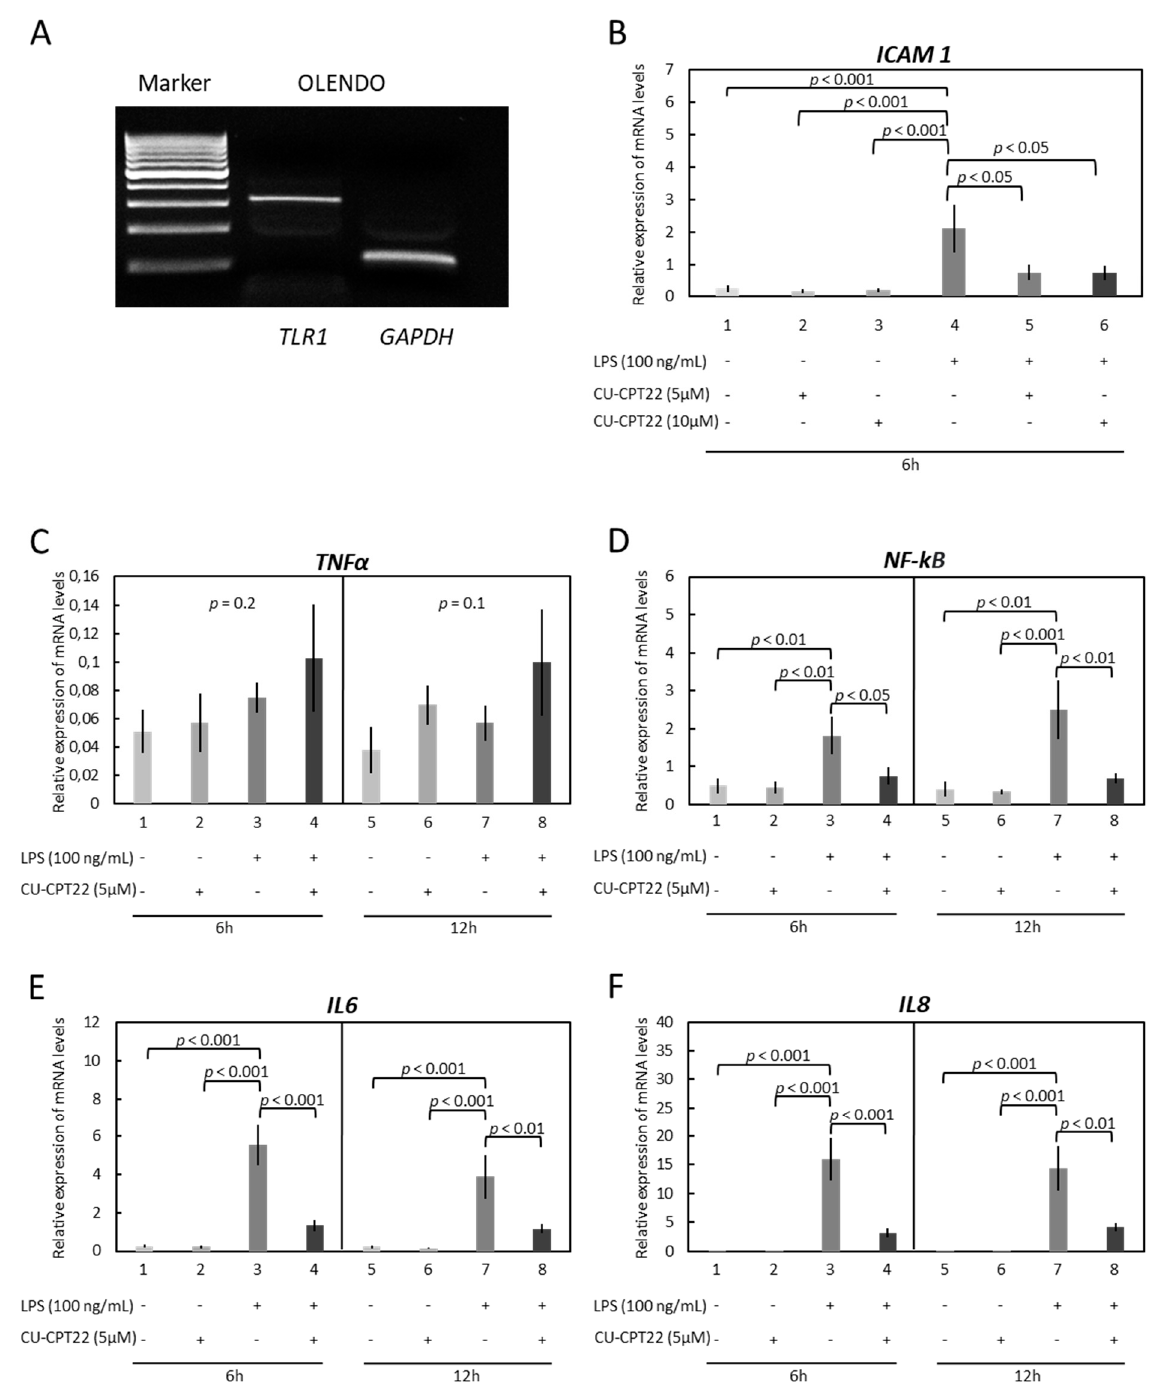
Figure 2. The expression of TLR1 and effects of LPS treatment and functional blocking of TLR1/TLR2 on expression of ICAM 1 , TNF α , NF-kB , IL6 , and IL8 in immortalized OLENDO cells. ( A ) The expression of TLR1 in OLENDO cells (317 bp) by qualitative PCR (M = marker, GAPDH as internal control). Expression of ICAM 1 ( B ), TNF α ( C ), NF-kB ( D ), IL6 ( E ), and IL8 ( F ) as determined by real-time (TaqMan) PCR. A selective blocker of TLR1/TLR2 (CU-CPT22) was used as described in the Materials and Methods. A parametric one-way ANOVA was applied followed by the Tukey–Kramer multiple comparisons post-test. All numerical data are presented as the means ± S.D. p -values < 0.05 were considered significant and are indicated. The original western blotting figures in Figure 2A can be found in Figure